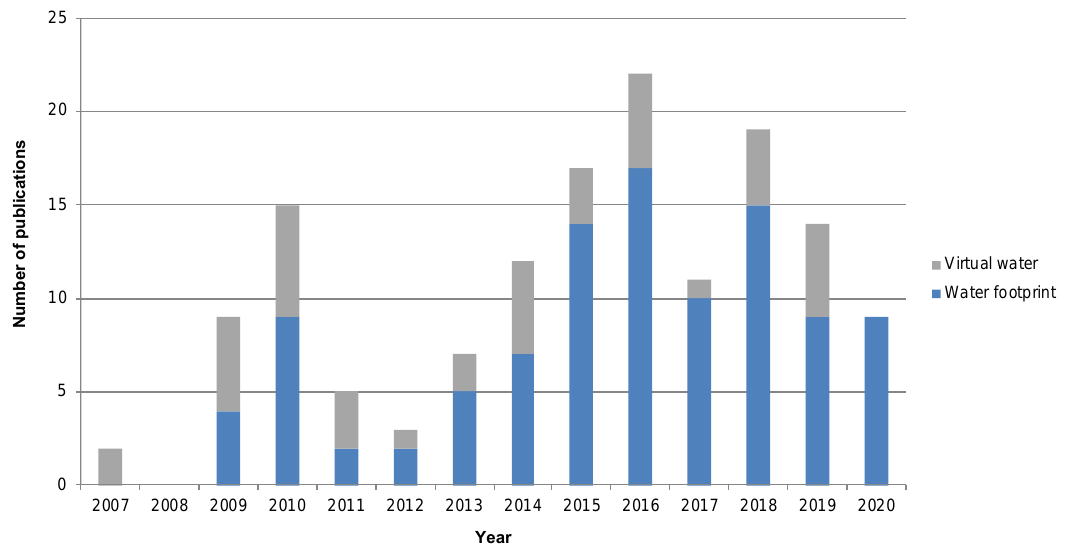
Figure 1. Number of publications per year using the terms “water footprint” and “Spain,” as well as “virtual water” and “Spain” during the period 2000–2020 according to the Web of Science (accessed 10 August 2020).